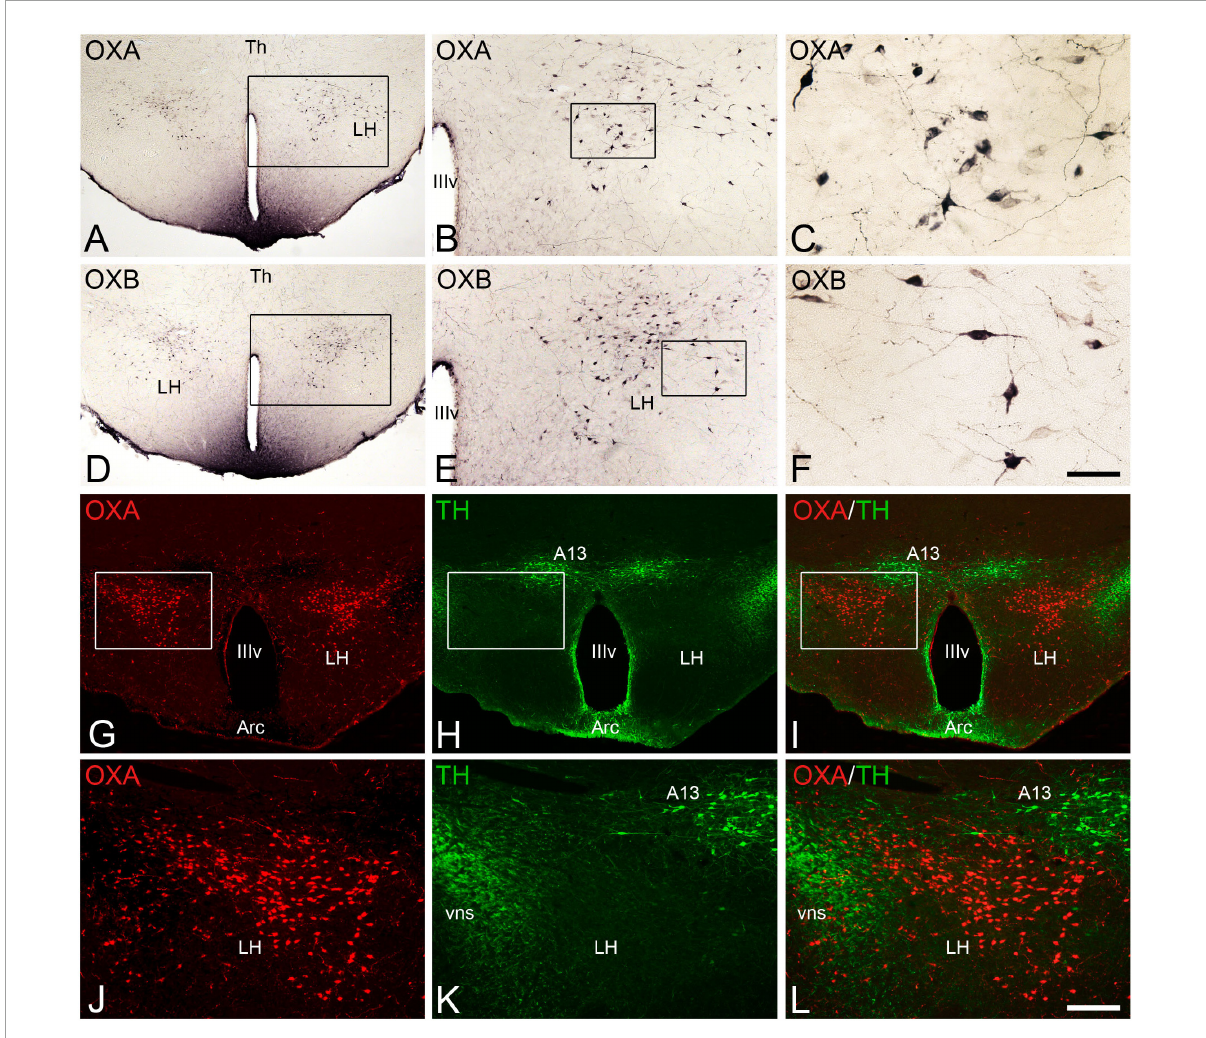
FIGURE1 (A–F) Photomicrographs of transverse sections through the hypothalamus of Mesocricetus auratus showing the distribution of orexinergic neurons that expressed the neuropeptides orexin A [OXA (A–C) ] or orexin B [OXB (D–F) ] in the lateral hypothalamic area. Squared areas in panels (A,B,D,E) are respectively shown at higher magnification in panels (B,C,E,F) . (G,H) Pair of fluorescence photomicrographs from an OXA/TH double-immunostained section through the hypothalamus of M. auratus showing the distribution of orexinergic neurons (red) and TH-ir catecholaminergic neurons (green). (I) Merged image generated from panels (G,H) . Squared areas in panels (G–I) are shown at higher magnification in panels (J–L) . A13, A13 catecholaminergic cell group or zona incerta; Arc, arcuate nucleus; LH, lateral hypothalamus; Th, thalamus; vns, fibers of the nigrostriatal pathway; IIIv, third ventricle. Scale bar, shown in panel (F) , indicates 530 µ m in panels (A,D) , 210 µ m in panels (B,E) , and 50 µ m in panels (C,F) . Scale bar, shown in panel (L) , indicates 200 µ m in panels (G–I) , and 100 µ m in panels (J–L)